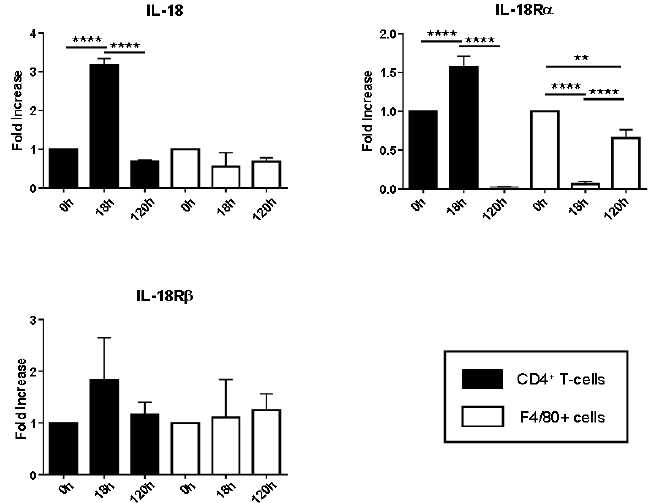
Figure 1. Lipopolysaccharide (LPS) affects the expression levels of interleukin (IL)-18, IL-18R α and IL-18R β in the mouse kidney. C57BL/6 mice were injected intraperitoneally with 30 mg/kg LPS and sacrificed at 18 and 120 h after LPS injection. At 18 and 120 h, CD4 + T cells and F4/80 + cells were isolated using a BD FACSAria TM special-order research product with purities of 90–95% from splenocytes in C57BL/6 WT mice. Gene expressions of IL-18, IL-18R α and IL-18R β were measured by real-time PCR. In each experiment, the expression levels were normalized to the expression of 18SrRNA and were expressed relative to the values of saline-treated control mice. The data are the mean fold-increase ± SEM: ** p < 0.01, **** p < 0.0001, the mice without and with LPS injection at 0 and 120 h ( n = 4 and n = 6) vs. 18 h ( n = 4) after LPS injection.